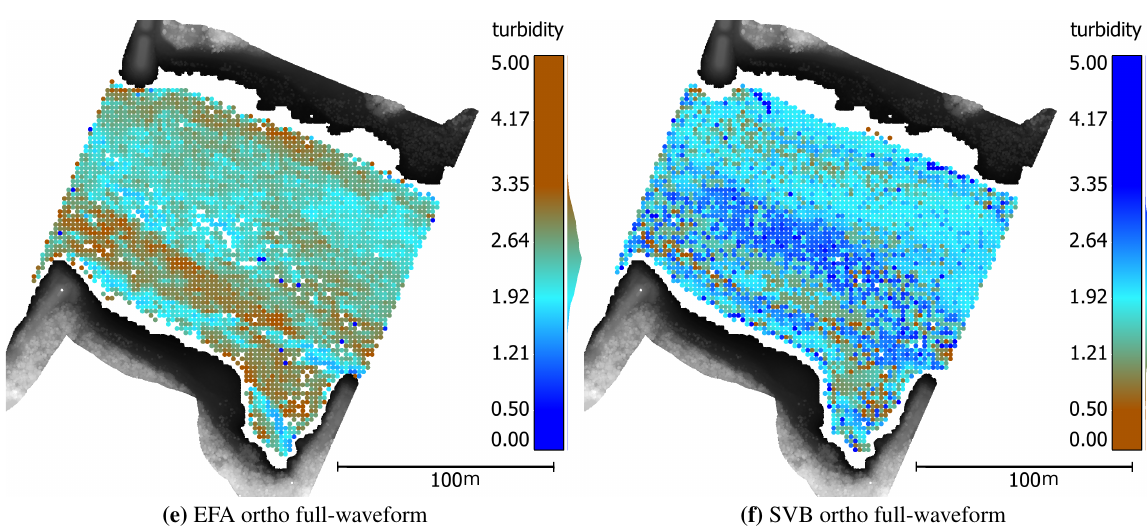
Figure 10. Visualization of determined volume exponential decay coefficients; (a,c,e) exponential function approximation; (b,d,f) and SVB